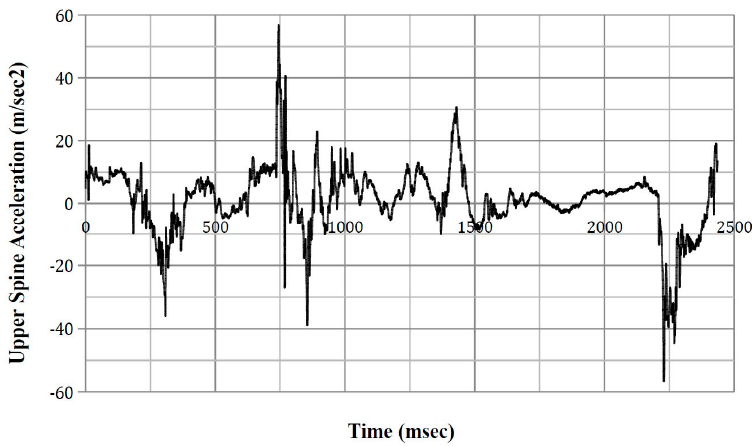
Figure A13. ATD Position 8 upper spine acceleration.